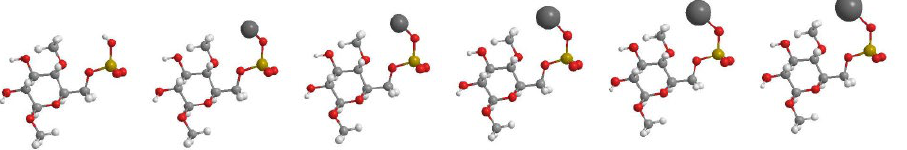
Figure 1. Illustration of the structure of cellulose anhydroglucose unit (AGU) with sulfate half ester group with H + , Li + , Na + , K + , Rb + , and Cs + counter ion. The illustration was prepared using Chemdraw and is not a result of modeling.